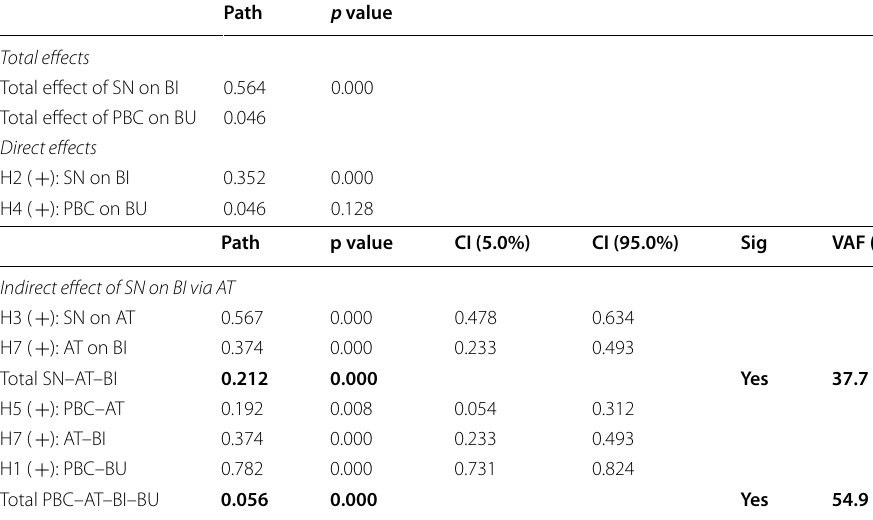
Table 8 Summary of Mediating